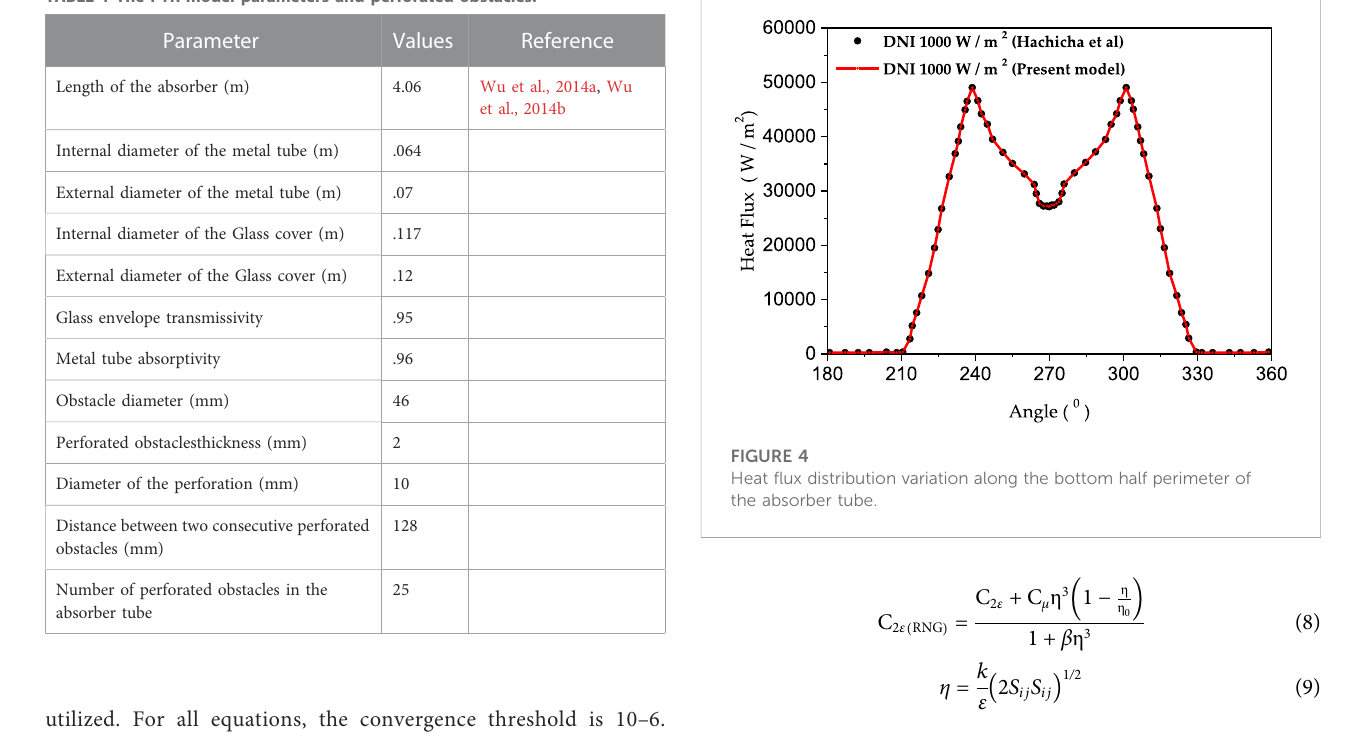
TABLE 1 The PTR model parameters and perforated obstacles.